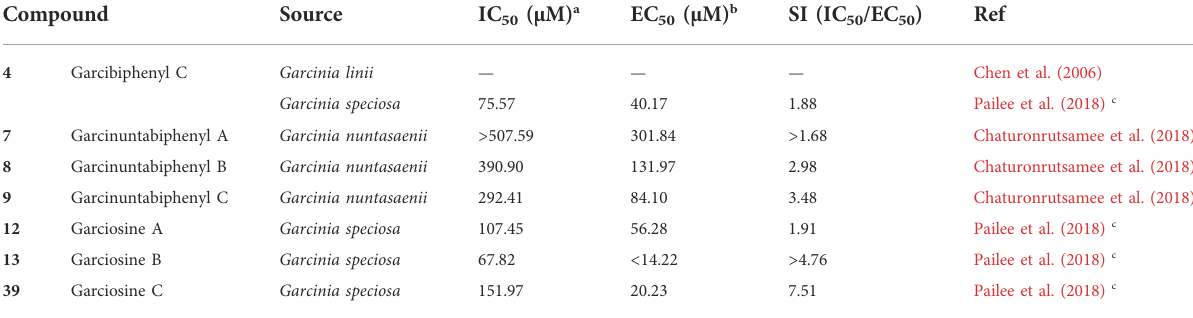
TABLE 5 Biphenyls from Clusiaceae and associated anti-syncytium activity.